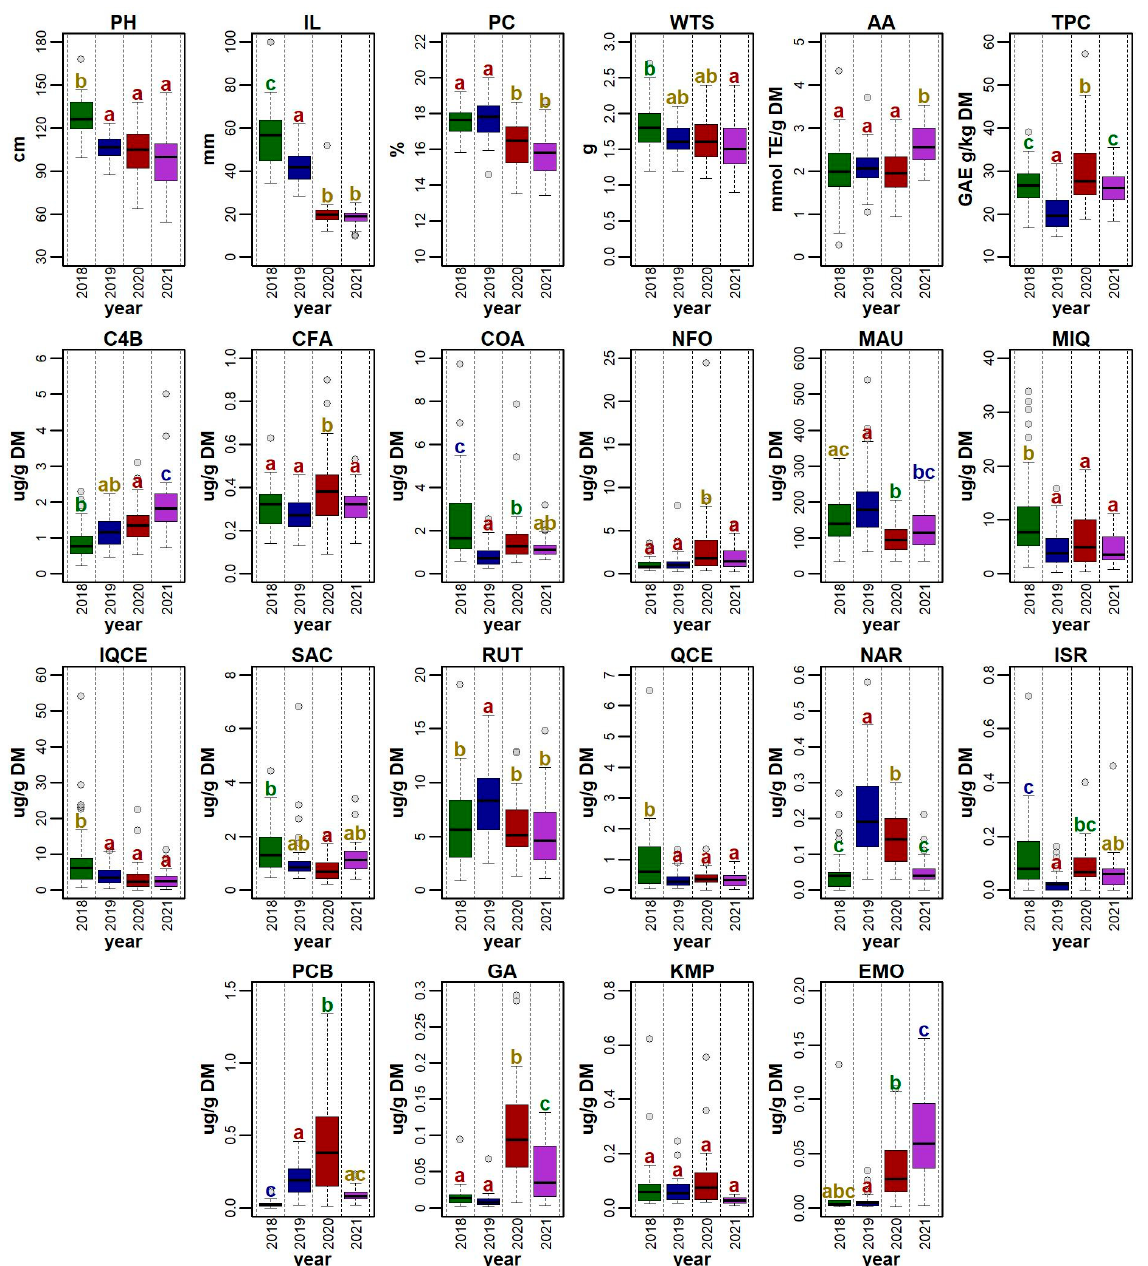
Figure 2. Distribution of values for a set of 22 morpho-phenological parameters and chemical compounds observed for 41 quinoa genotypes grown in the Czech Republic between 2018 and 2021. For each descriptor, the values recorded for each accession in a given year were used for the plot. Boxplots show the distribution of values, with grey shaded points representing outlier values. Significant differences in means between years are denoted by the different letters (Tukey HSD) above each boxplot. The abbreviations for the selected descriptors are as follows: plant height (PH), inflorescence length (IL), protein content (PC), weight of thousand seeds (WTS), antioxidant activity (AA), total polyphenols (TPC), 4-hydroxybenzaldehyde (C4B), caffeic acid (CFA), p -coumaric acid (COA), N-feruloyloctopamine (NFO), mauritianin (MAU), miquelianin (MIQ), isoquercetin (IQCE), salicylic acid (SAC), rutin (RUT), quercetin (QCE), naringenin (NAR), isorhamnetin (ISR), pinocembrin (PCB), gallic acid (GA), kaempferol (KMP), and emodin